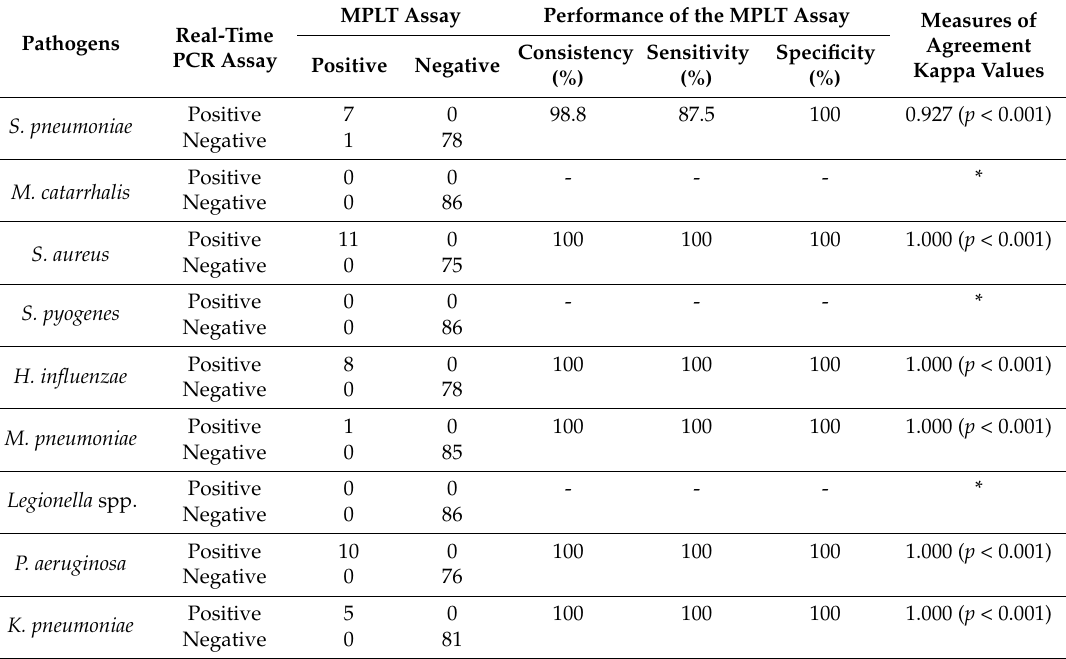
Table 4. Performance of the MPLT assay compared to the real-time PCR